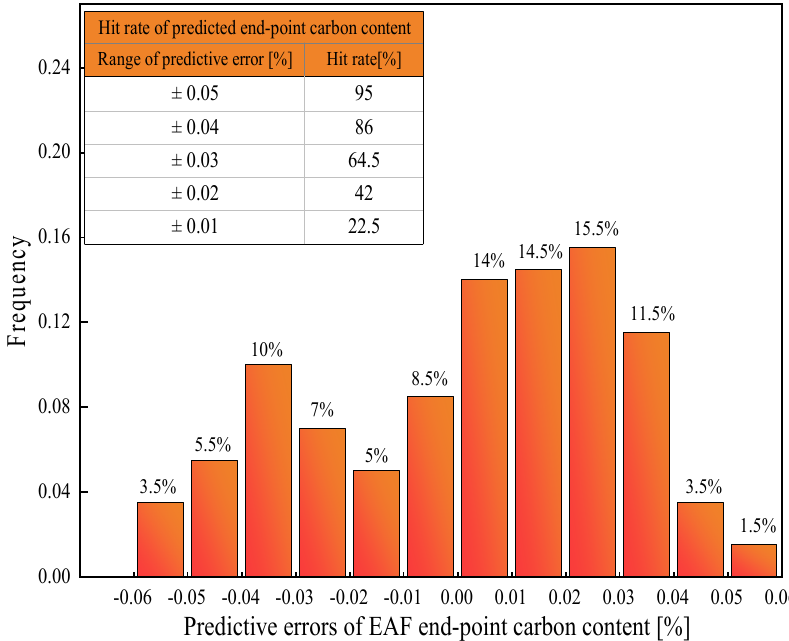
Figure 6. Frequency distribution of predictive errors for ANN model.